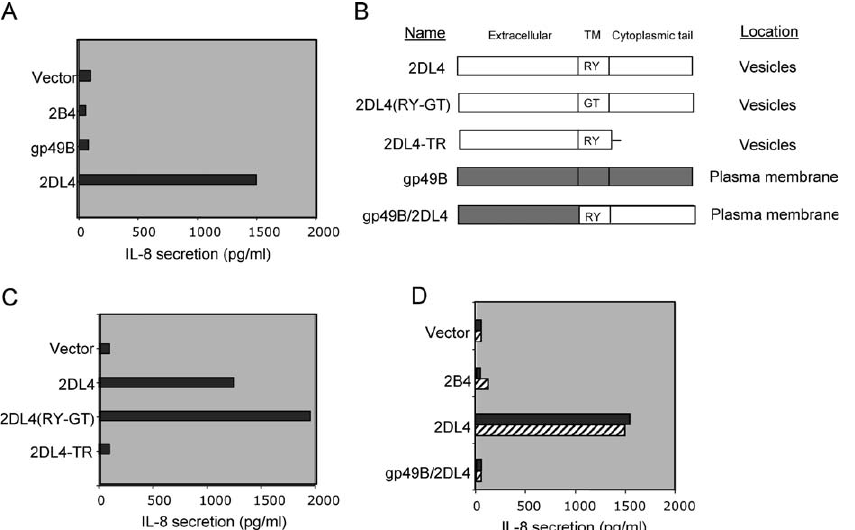
Figure 12. IL-8 Secretion Induced by KIR2DL4 Is Independent of the Transmembrane Arginine Residue and Requires Trafficking to Intracellular Vesicles (A) Expression of KIR2DL4 in 293T cells induces IL-8 secretion. The 293T cells were transfected with HA-tagged 2B4, gp49B, and KIR2DL4. After 48 h, culture supernatants were tested for IL-8 by ELISA. (B) Schematic representation of KIR2DL4 variants used in this study. Receptor localization was determined by confocal analysis of immunofluorescence staining of 293T cells transfected with the indicated constructs for 48 h. (C) IL-8 secretion induced by KIR2DL4 mutants in 293T cells. The 293T cells were transfected with HA-tagged KIR2DL4, KIR2DL4(RY-GT), and KIR2DL4-TR. After 48 h, culture supernatants were tested for IL-8 by ELISA. Transfection efficiency was verified by monitoring HA-positive cells by confocal microscopy. (D) Cell surface–expressed gp49B/2DL4 chimera does not induce IL-8 secretion. The 293T cells were transfected with HA-tagged 2B4, KIR2DL4, and gp49B/2DL4 chimera, as indicated. After 48 h, beads coated with control IgG (solid bars) or anti-HA mAb (hatched bars) were added at four beads per cell. Twelve hours later, culture supernatants were tested for IL-8 secretion. The percentage of 293T cells expressing receptor at the cell surface was monitored by HA staining and flow cytometry, and was as follows: vector control, 2%; 2B4, 39%; KIR2DL4, 9%; gp49B, 31%; gp49B/2DL4,